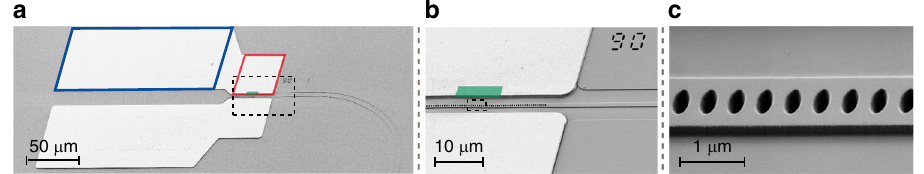
Fig. 2 Scanning electron microscopic (SEM) image of a fabricated EOM device. a Full SEM image of the whole-device structure. The region highlighted in red is the electrode used to drive the photonic-crystal nanoresonator. That highlighted in blue indicates the large metal pad used for contacting the RF probe. The green region indicates the electrode that can be shrunk to in the future design. b Zoom-in image of the photonic-crystal resonator and electrodes, corresponding to the dashed rectangular region in a . c Further zoom-in image showing the detailed structure of the photonic-crystal defects cavity, corresponding to the dashed rectangular region in b